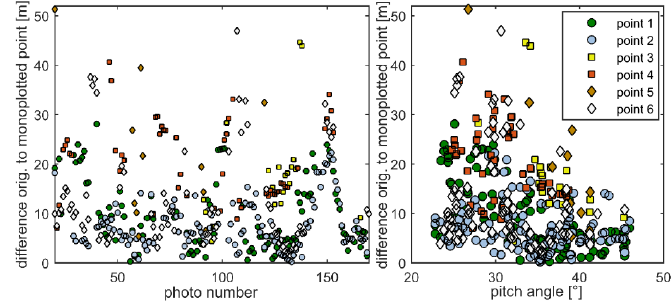
Figure 8. Distances of mapped points to reference positions in the orthophotograph real positions; ( left ) ordered by photo number; ( right ) ordered by pitch angle.